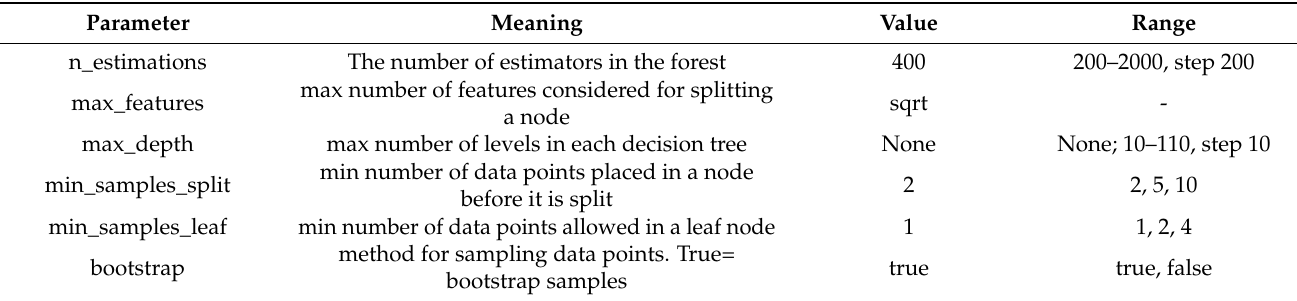
Table 2. RF hyperparameters.